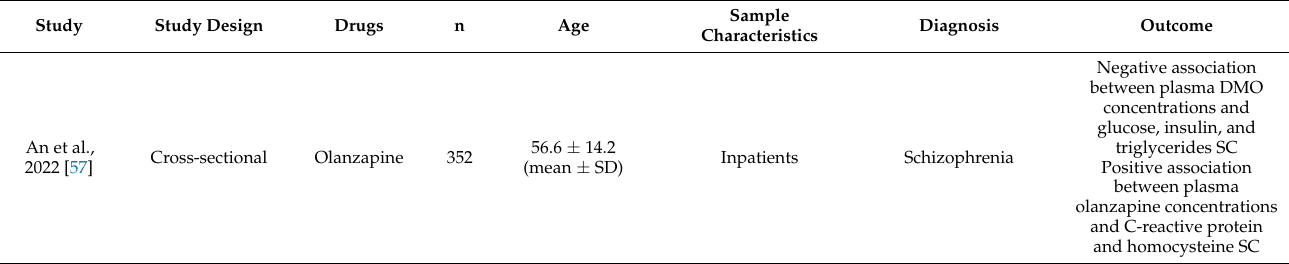
Table 3. Original articles on the use of TDM to ensure treatment